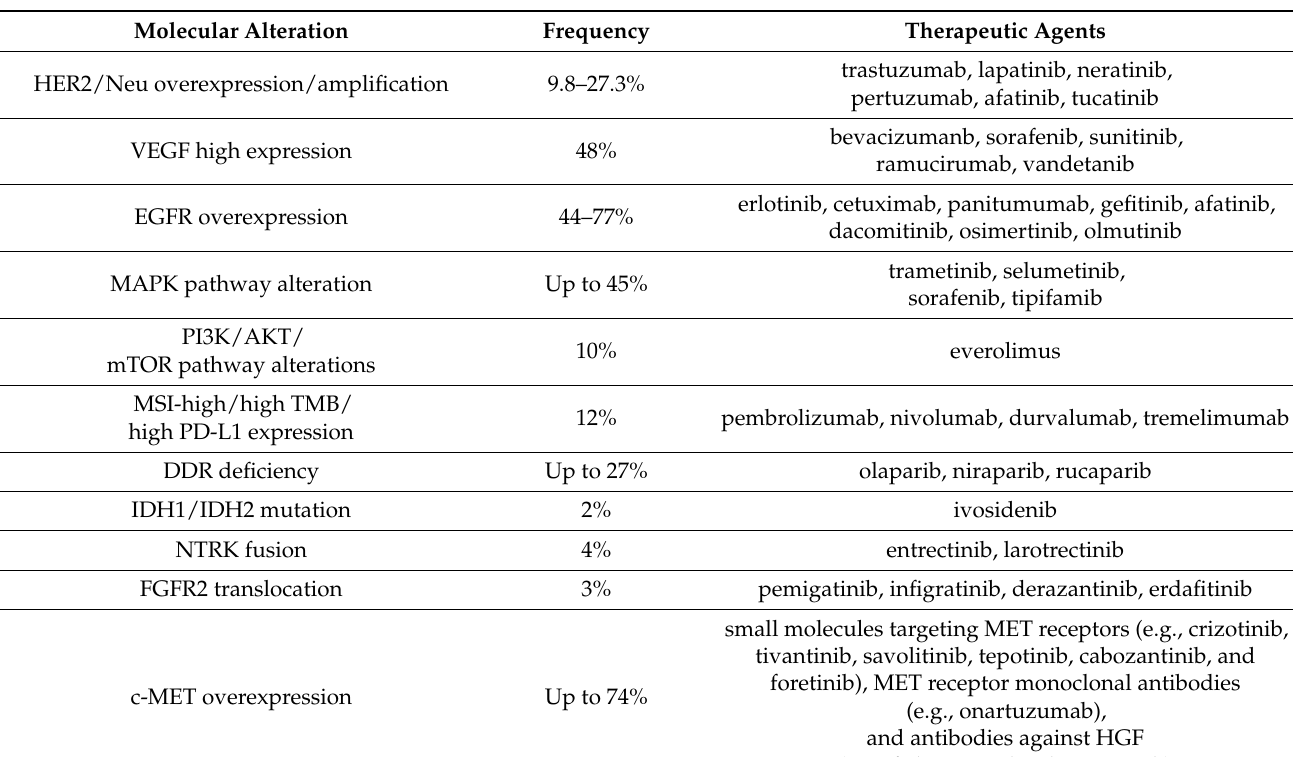
Table 3. Overview of targetable molecular alterations in